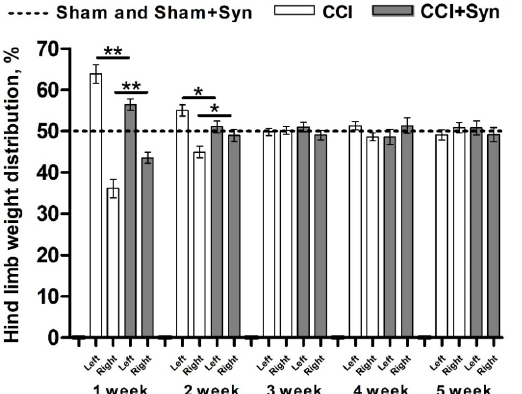
Figure 1. Hind limb weight distribution in neuropathic pain condition and following synaptamide treatment, mean ± SEM, n = 14 (number of animals/group) * p < 0.05, ** p < 0.01 (Mann-Whitney test). “Sham”—sham-operated animals that received vehicle treatment; “Sham + Syn”—sham-operated rats that underwent synaptamide administration; “CCI”—animals with chronic constriction injury of the sciatic nerve that received vehicle treatment; “CCI + Syn”—synaptamide-treated rats with chronic constriction injury of the sciatic nerve that underwent synaptamide